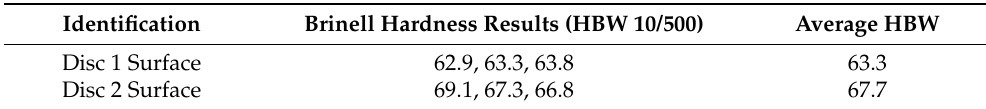
Table 5. Bracket Hardness Test Results.